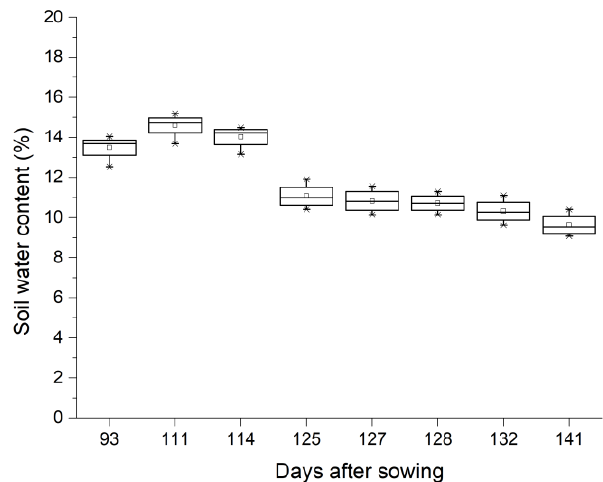
Figure 9. The variation in soil water content from anthesis until the end of grain filling (during Exp 2). Broad lines are medians, square open dots are means, boxes show the interquartile ranges, and whiskers extend to the last data points within 1.5 times the interquartile ranges.